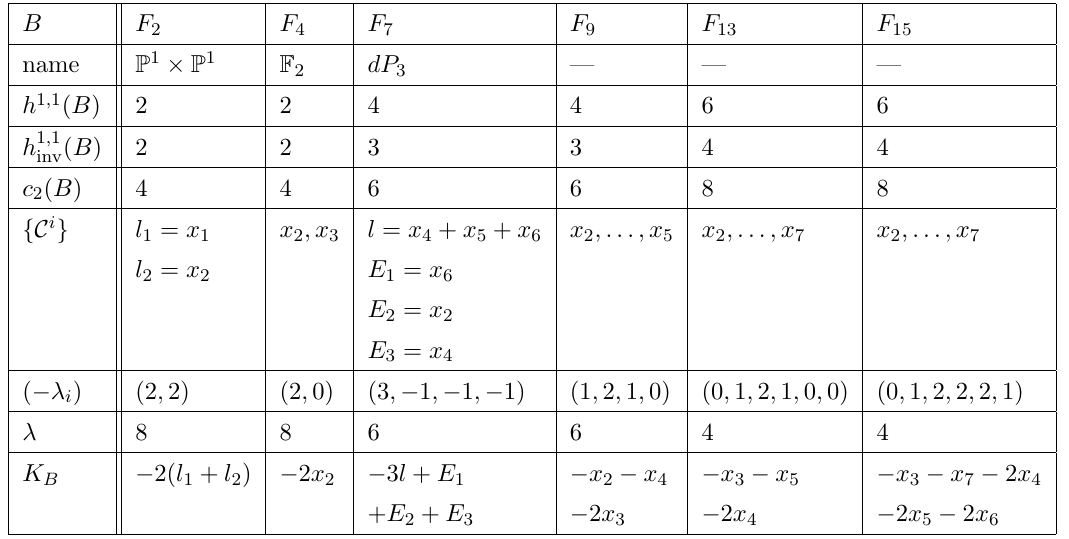
Table 1 . Some basic properties of the six toric bases spaces B which lead to smooth